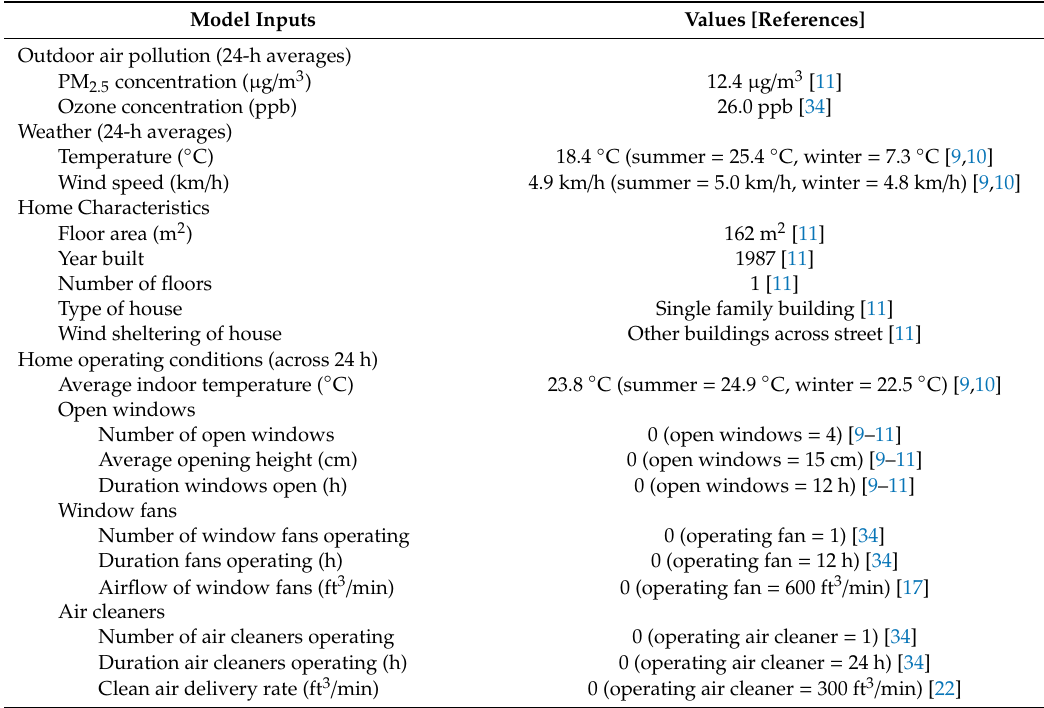
Table 3. Sensitivity analysis: inputs for outdoor air pollution, weather, home characteristics, and home operating